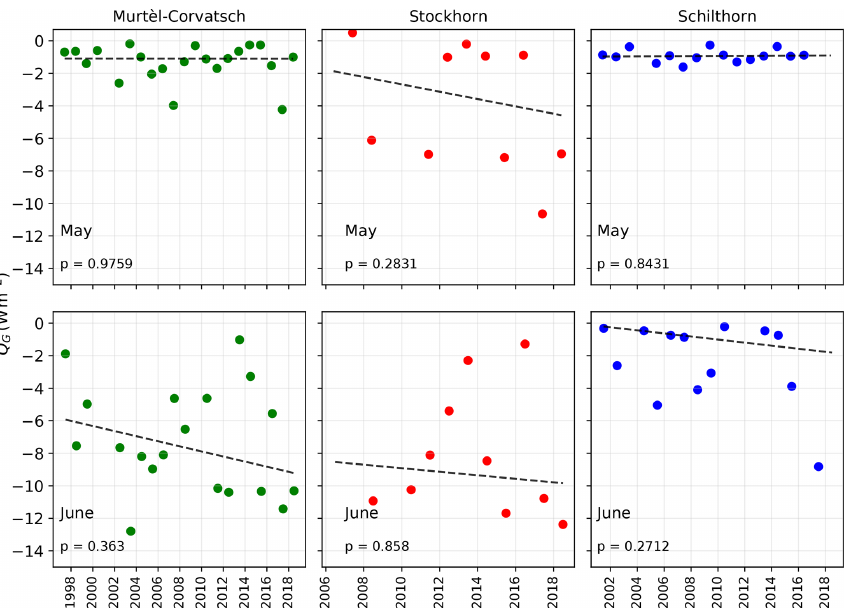
Figure 8. Mean ground heat fluxes for the months of May and June for all observation years and for all three stations: Murtèl–Corvatsch (1997–2018), Schilthorn (1999–2018) and Stockhorn (2006–2018). P values were calculated using the Mann–Kendall test with a 95% confidence interval. The decreasing trends in the plots are statistically